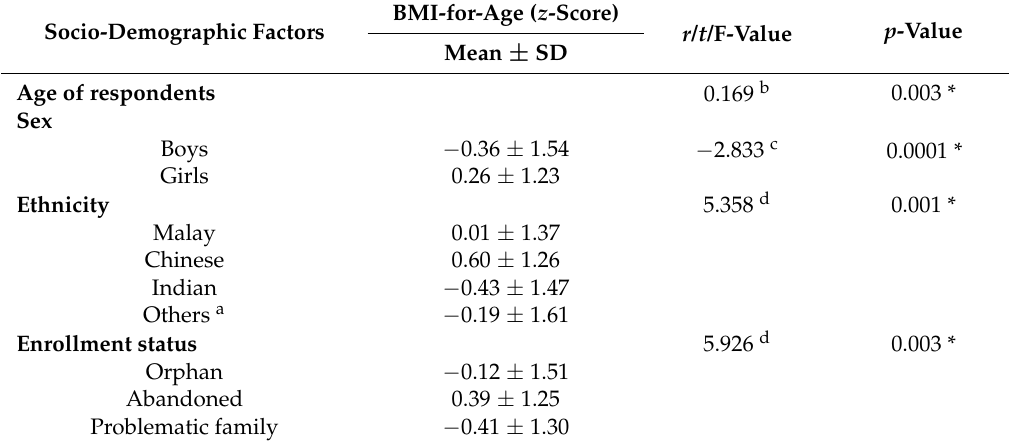
Table 2. Association between socio-demographic factors and BMI-for-age ( z -score) ( N = 307).